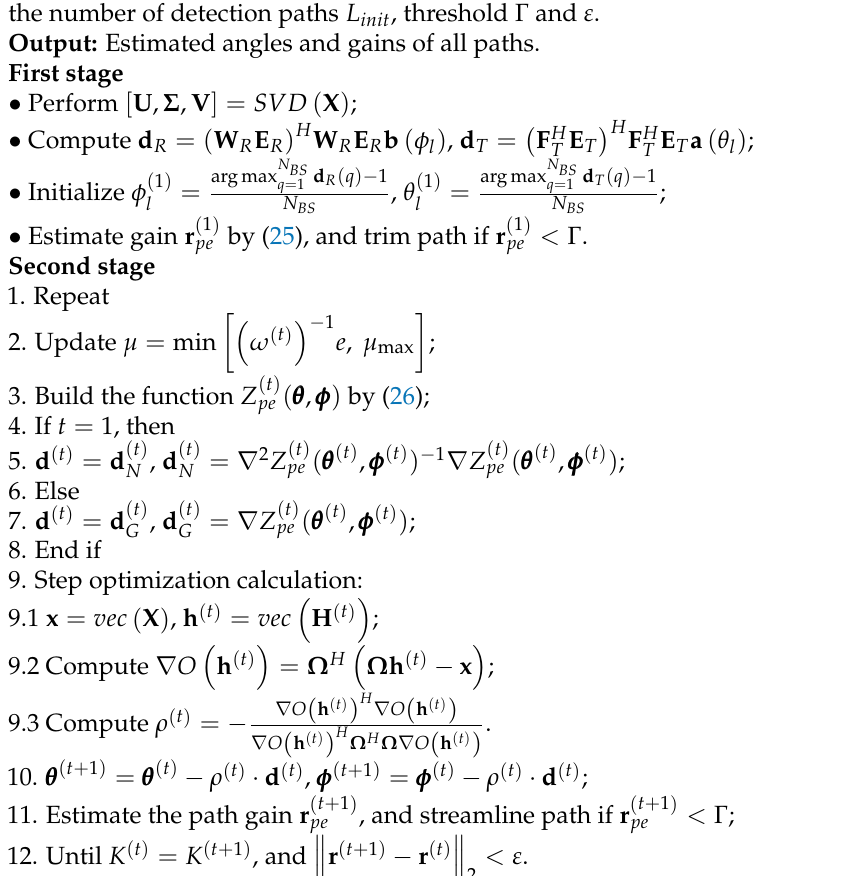
Algorithm 1 The optimized iterative